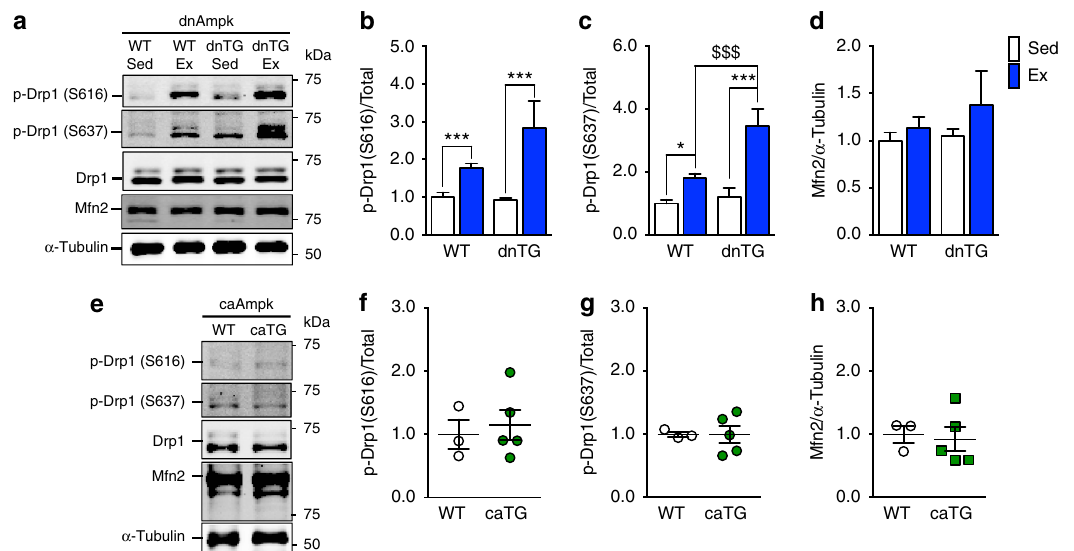
Fig. 4 Ampk is not required for exercise-induced phosphorylation of Drp1. Phosphorylation of Drp1 at S616 and S637 is signi fi cantly increased in dnTG mice post-exercise ( a – c ), while there was no effect of caTG Ampk on phosphorylation of Drp1 at either S616 e , f or S637 e , g under sedentary conditions. There was no effect on Mfn2 protein abundance in either dnTG mice, regardless of exercise d , or sedentary caTG mice h . Representative western blots are shown a , e and all quanti fi cation is presented as protein phosphorylation to total protein abundance ratio b , c , f , g or total protein d , h . Data are presented as mean ± standard error of the mean. For dnTG study n = 10 WT or 5 – 7 dnTG (12 – 13 weeks). See also Supplementary Fig. 10. Results of two-way ANOVAs are * p < 0.05, *** p < 0.001, for sedentary vs. exercise comparisons, F = 19.39, DF = 1 ( b ). Tukey multiple comparison tests were performed when a signi fi cant interaction effect was observed, in which * p < 0.05, *** p < 0.001 for WT sedentary vs. WT exercise comparisons and $$$ p < 0.001 for WT exercise vs. dnTG exercise comparisons, DF = 26. For caTG study n = 3 WT or 5 caTG (13 – 15 weeks). Results of two-tailed t -tests are t = 0.42 ( b ), t = 0.02 ( c ), t = 0.29 ( d ), DF = protein 1 (Drp1) is an important GTPase that promotes mitochondrial fi ssion when phosphorylated at S616 40 . We found that phosphorylation of Drp1 at this site (S616) was transiently increased immediately following treadmill running (Fig. 2a, g).